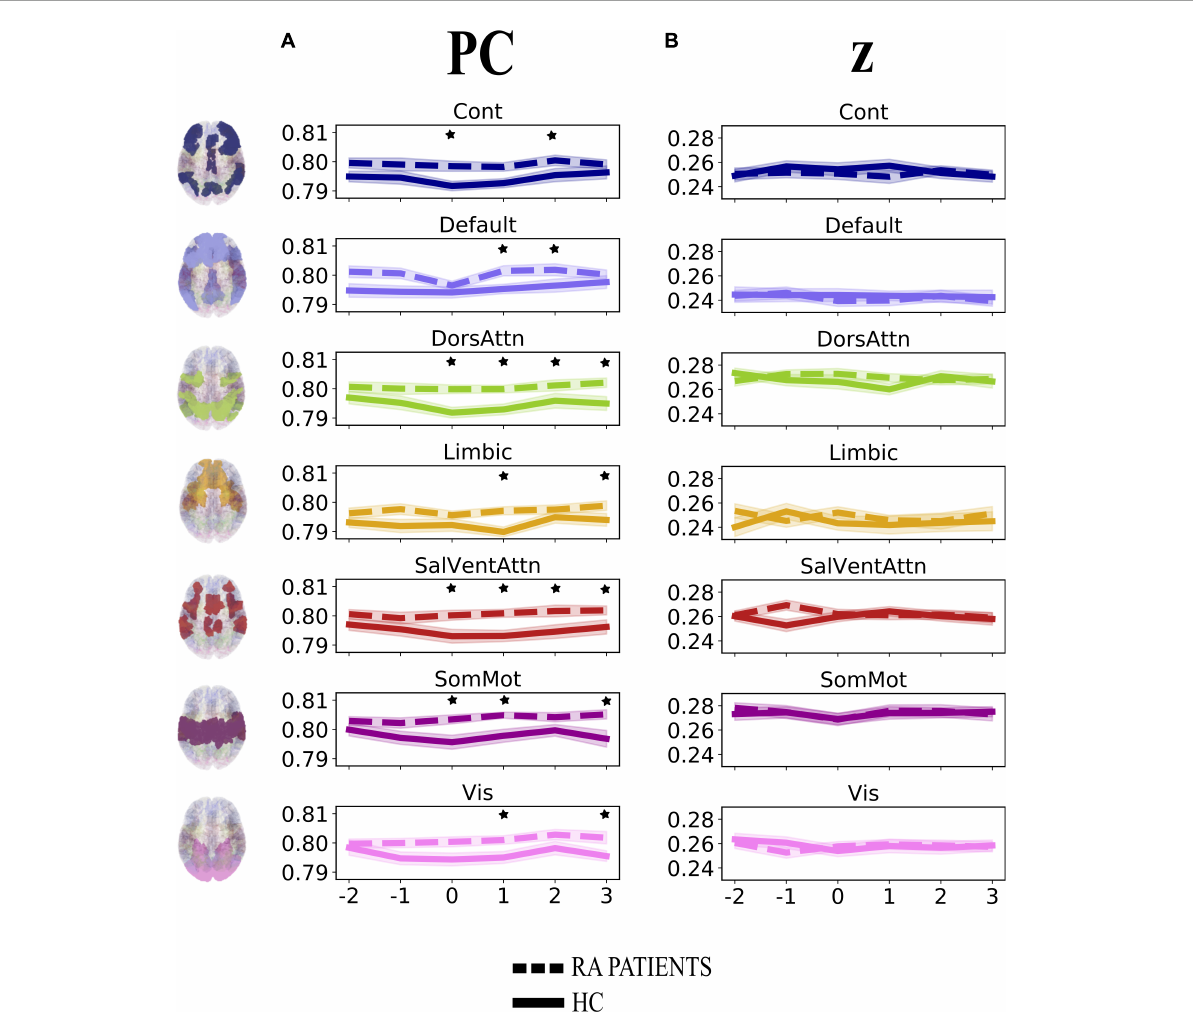
FIGURE3 Degree of change in community-related integration (A) and segregation (B) per time point for rheumatoid arthritis (RA) patients and healthy controls (HC), when pain was delivered to the diseased joint and corresponding site in HC. Displayed are the average parameter values (PC, z ) over trials per time point. Time points are indicated as –2, –1, 0, +1, +2, +3 on the x -axis, with 0 representing the onset TR (TR = 3 s) of painful stimulation, –2 and –1 being the two TR pre-stimulation, whereas + 1, +2, and +3 the three TR after-stimulation. The brain plots on the left side of the figure represent each of the seven Yeo communities (Yeo et al., 2011). The shaded areas contouring the lines represent the standard error of the mean. The stars represent time points that differed significantly ( p < 0.05, FDR corrected) between groups. PC, participation coefficient; z , within-module degree z -score; RA, rheumatoid arthritis; HC, healthy